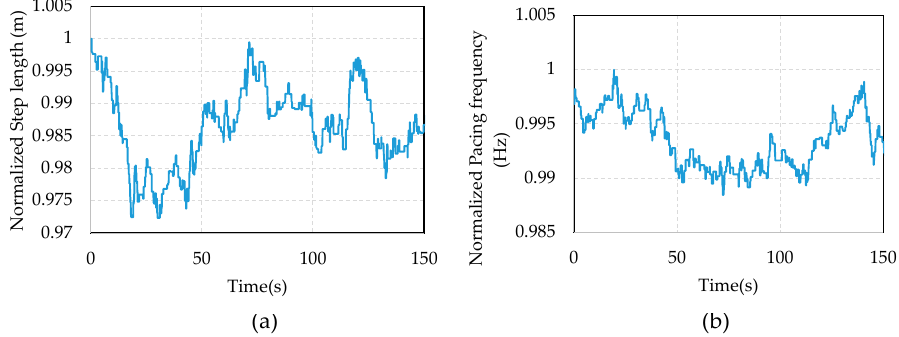
Figure 1. Example of random walk (RW) series of the ( a ) step length and ( b ) pacing frequency.